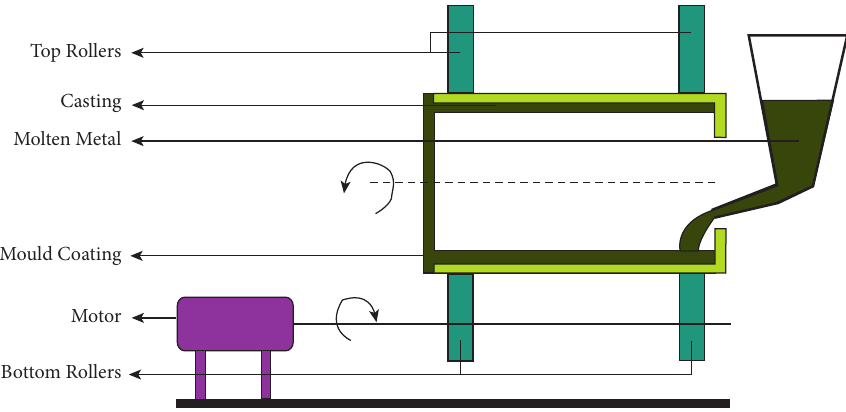
Figure 5: Centrifugal